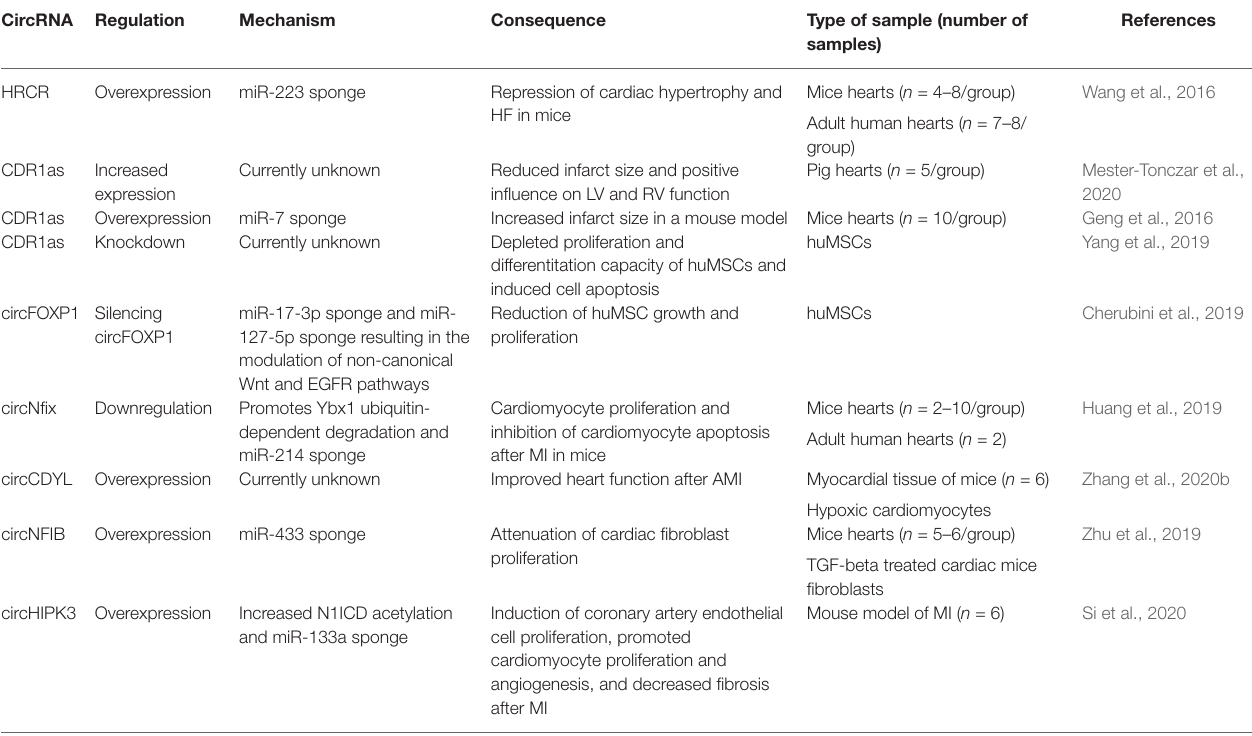
TABLE 2 | CircRNAs and their role in cardiac cell proliferation, differentiation, and cardiac